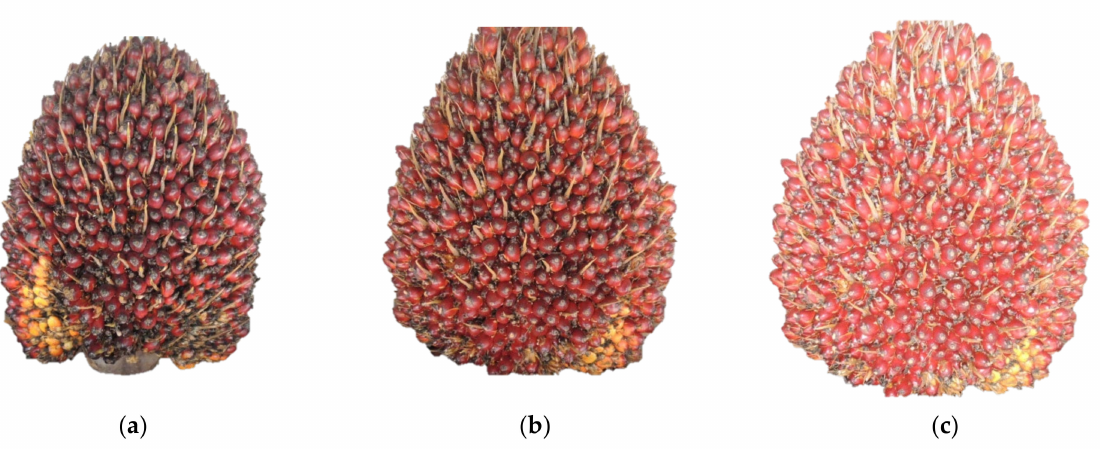
Figure 3. Oil palm fresh fruit bunches of cultivar Nigrescens based on maturity: ( a ) under-ripe, ( b ) ripe, and ( c ) over-ripe.